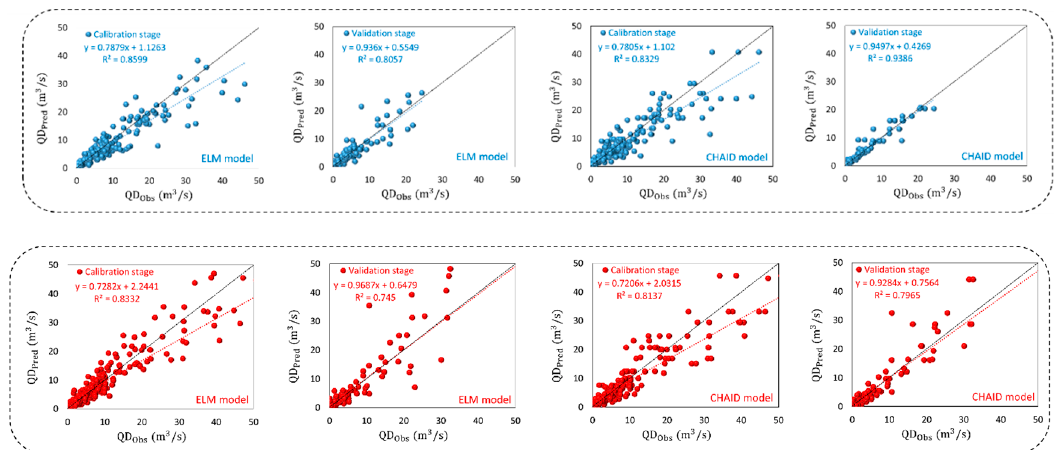
Figure 5. Scatter plots between the observed and the predicted value of streamflow for OPELM and CHAID models at Dizaj (blue color) and Tapik (red color) stations.